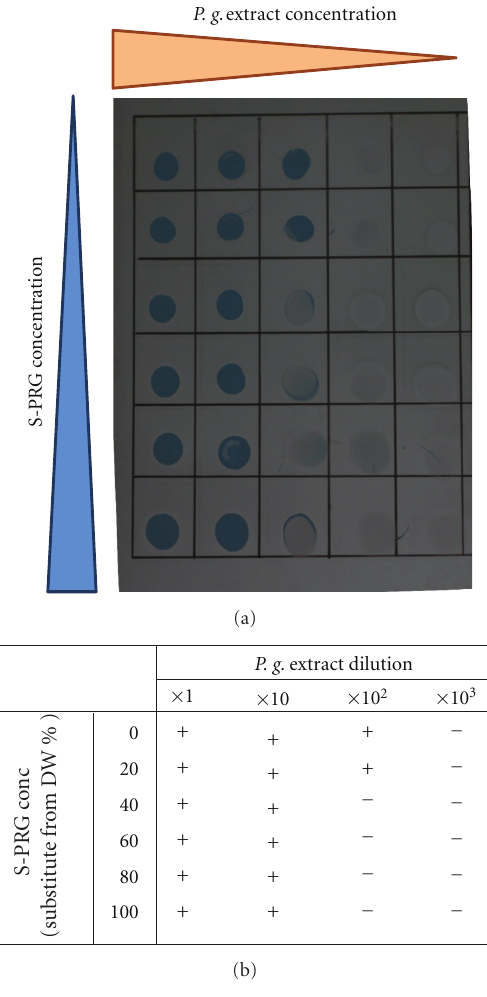
Figure 3: Gelatinase spot assay. Di ff erent amounts of S-PRG eluate were added to the reaction mixture. P.-gingivalis- sonicated extract was then added and the mixture was serially diluted with distilled water. A 15 μ L spot of each mixture was placed onto gelatin-coated X-ray film and incubated at 37 ◦ C for 2h in a humidified atmosphere before being washed with tap water. Removal of the gelatin surface beneath the spotted area revealed the base color of the film and indicated the presence of gelatinase activity. (a) Photograph of X- ray film after assay. (b) Results of gelatinase spot assay.